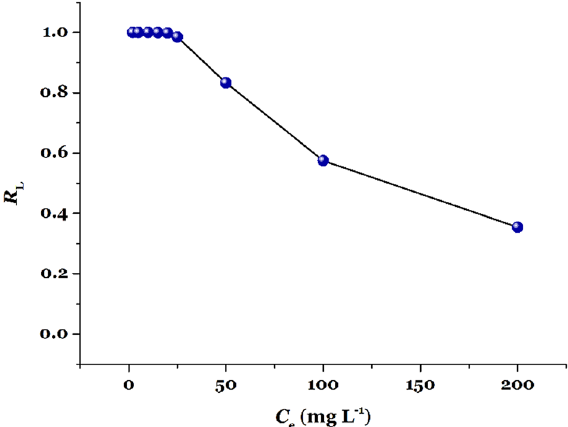
Figure 8. The R L values for adsorption of Hg(II) onto TSF-KCC-1.